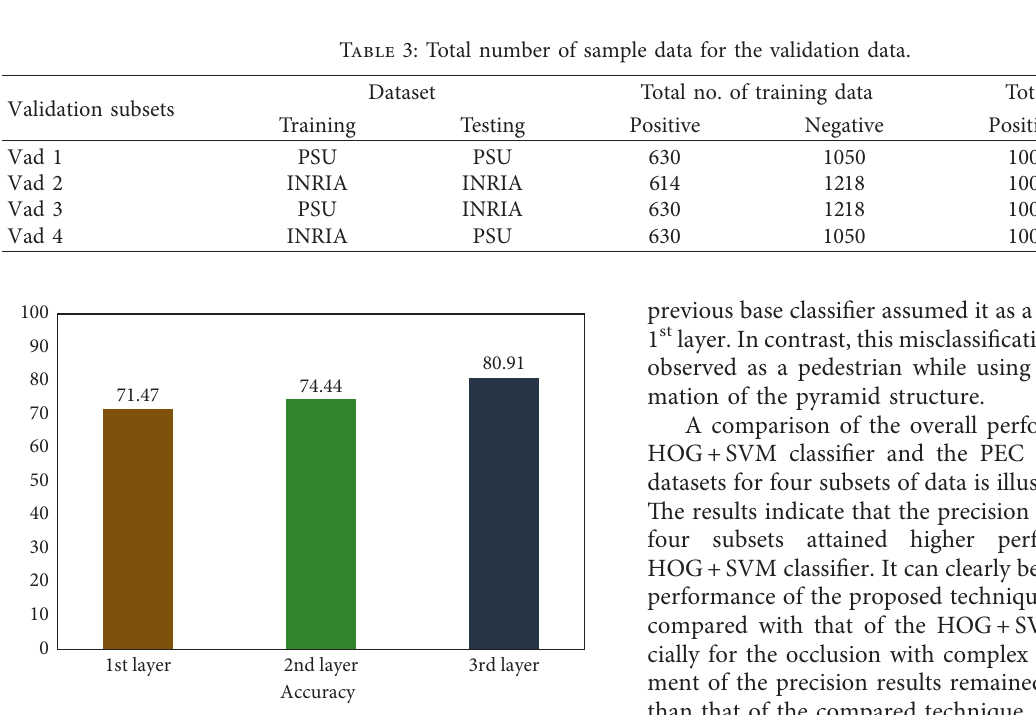
Figure 8: Performance comparison of each pyramid layer